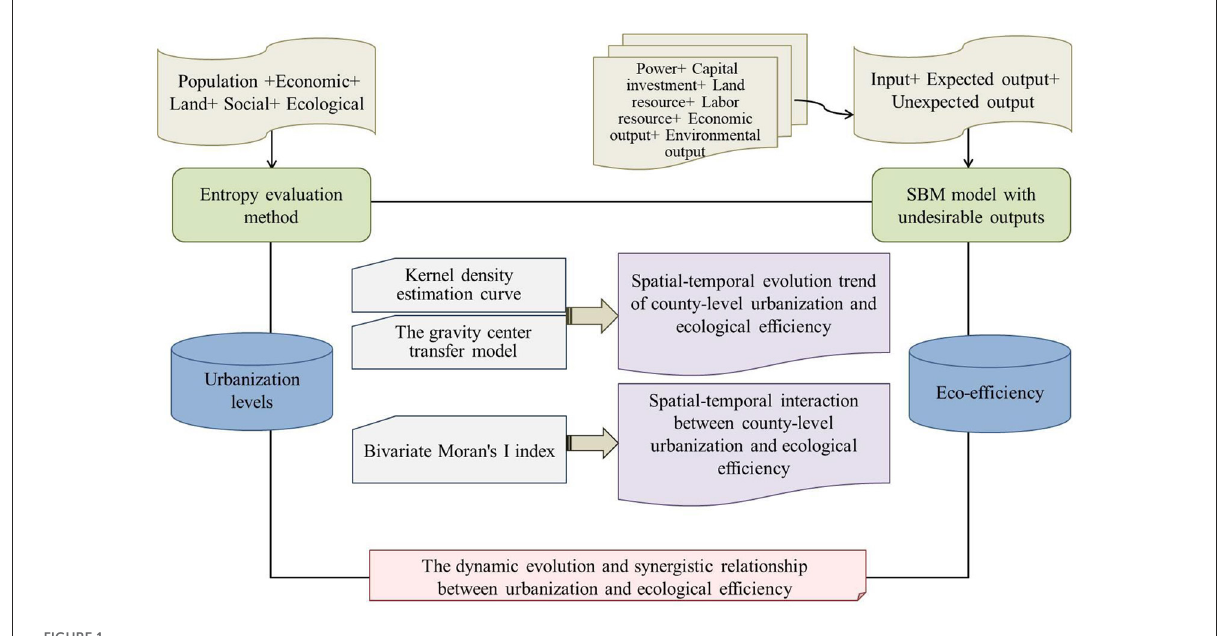
FIGURE1 Method flow chart of the